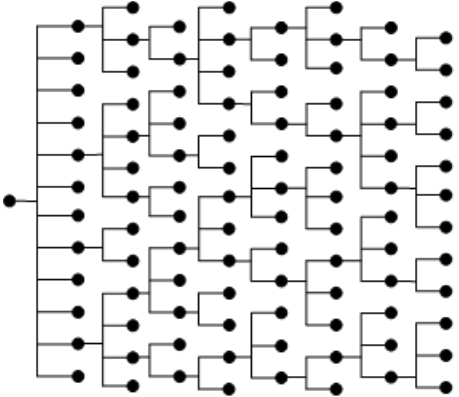
Figure 2. Structure of clock network.